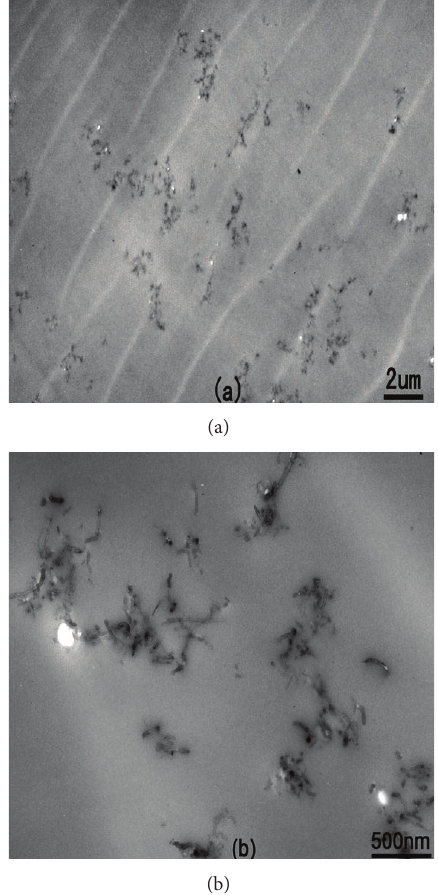
Figure 8: TEM of different MWNTs nanocomposites with 1% and